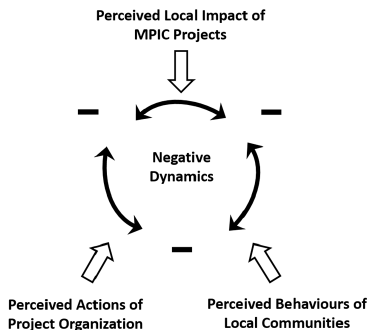
Figure 1. Negative dynamics at the local level of MPIC projects, adapted from Di Maddaloni and Davis (2018).